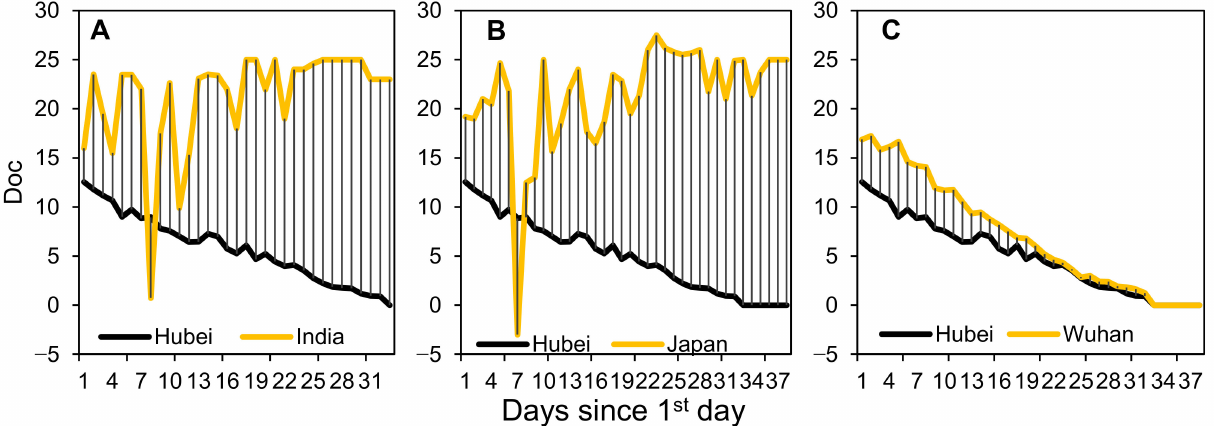
Figure 2. Dynamic D oc and sketch of indents. D oc in ( A ) India and Hubei, ( B ) Japan and Hubei, and ( C ) Wuhan and Hubei. Striped areas represent the difference in D oc and can be used to roughly estimate bed shortages within a certain